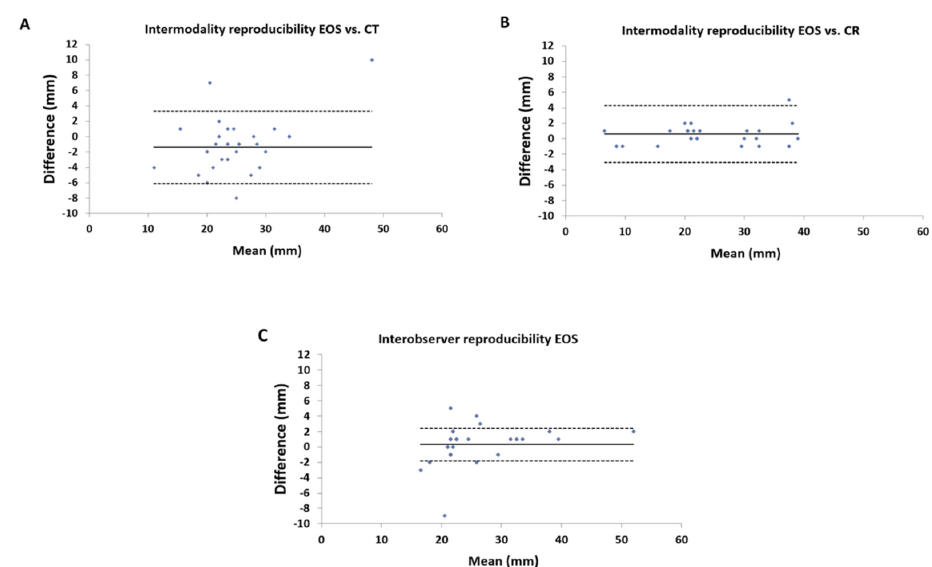
Figure 1. Intermodality and interobserver reliability of insert length measurements among di ff erent modalities and among di ff erent observers: ( A ) Intermodality reliability between EOS imaging system and computed tomography (CT) scanning. The mean of the measurements obtained with EOS and CT for each insert is reported on the x-axis; the di ff erence between the two measurements is reported on the y-axis. ( B ) Intermodality reliability between the EOS imaging system and conventional X-ray. The mean of the measurements obtained with EOS and X-ray for each insert is reported on the x-axis; the di ff erence between the two measurements is reported on y-axis. ( C ) Interobserver reliability between measurements obtained by two di ff erent observers with the EOS imaging system. The mean of the measurements is reported on the x-axis; the di ff erence between them is reported on the y-axis.